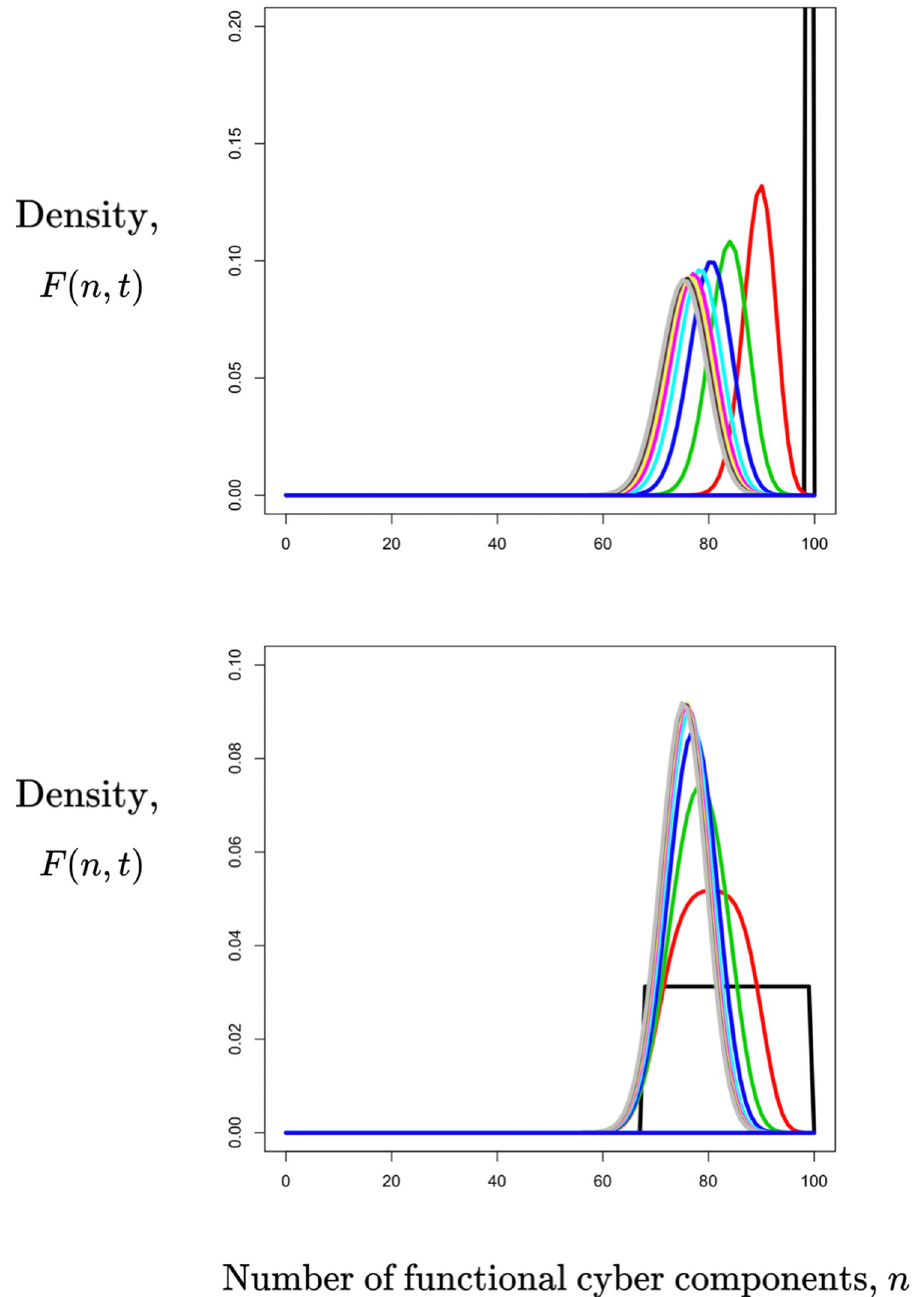
Fig 9. Numerical solution of the forward equation for p ud = 0.08 and p du = 0.2. In the upper panel, the initial number of functional components is concentrated at N 0 = 100; in the lower panel, it is uniformly distributed between 69 and 100. Each color corresponds to one time step into the future, and time increases as the curves move to the left. Note the different scales in the vertical axes.